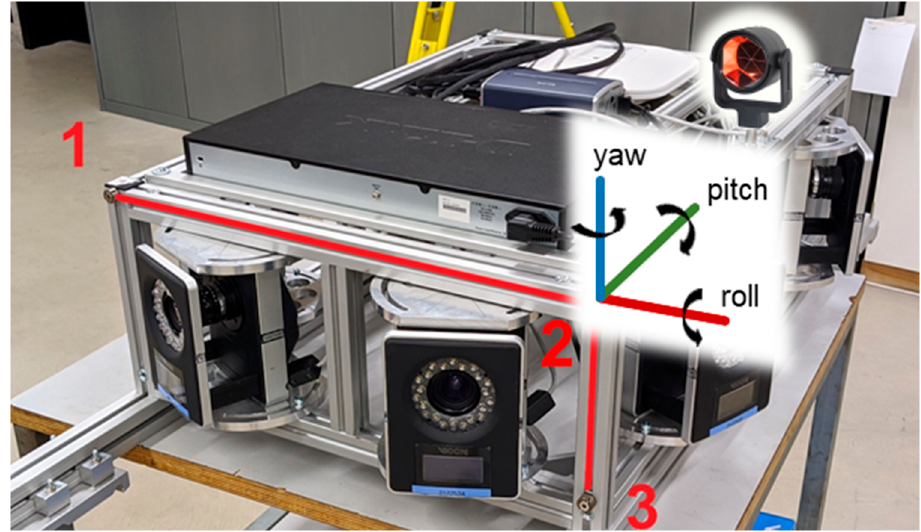
Figure 11. Points measured with the laser tracker. Points 1 to 3 are used for orientation, while the prism is used for positioning.